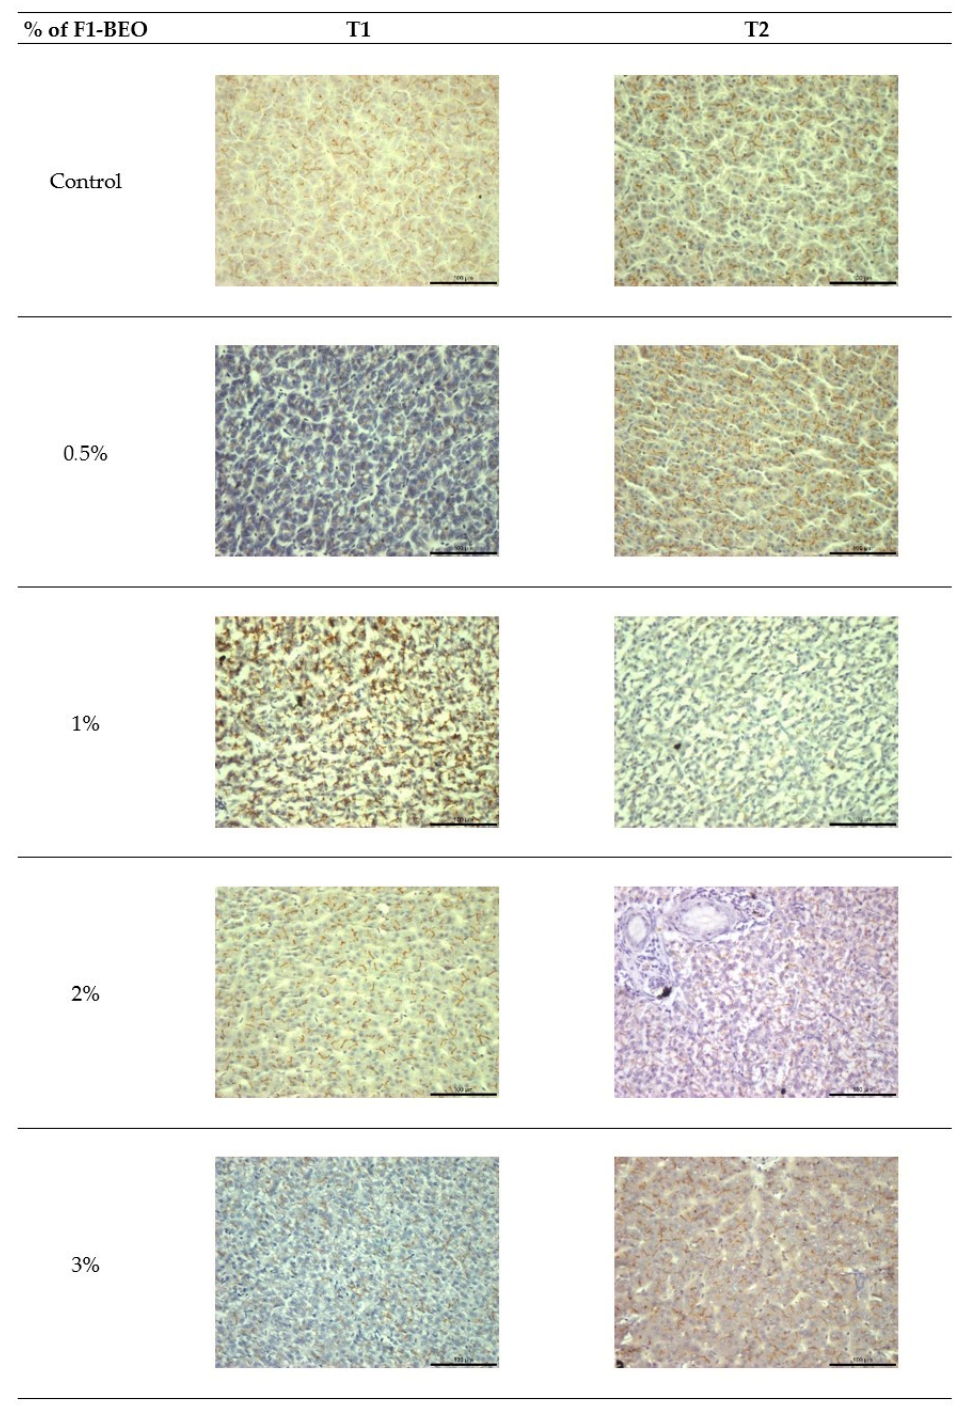
Figure 6. Immunohistochemistry assays to identify the TRPV1 receptor in liver specimens. The positivity is comprehensible due to the brownish color. T1 = 15 days. T2 = 30 days. Magnification: 20×.